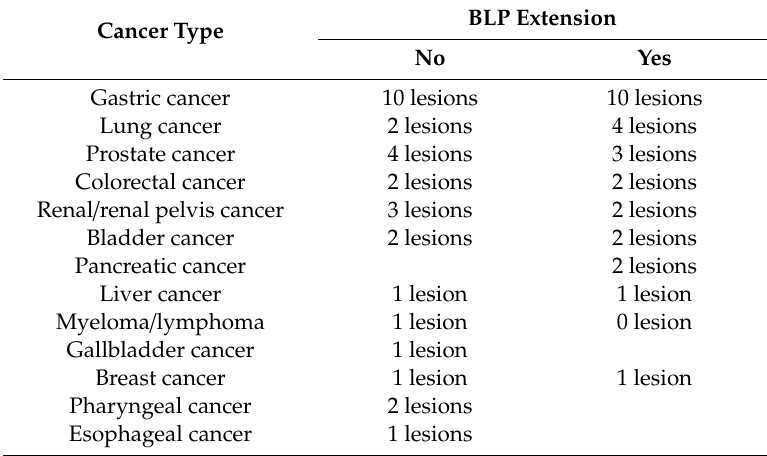
Figure 2. Cumulative cancer incidence in BLP extension group and non-BLP extension group. Dotted line: Treated with Biolactis. Solid line: Not treated with Biolactis. Table 2. Distribution of cancer types in patients with and without BLP extension.